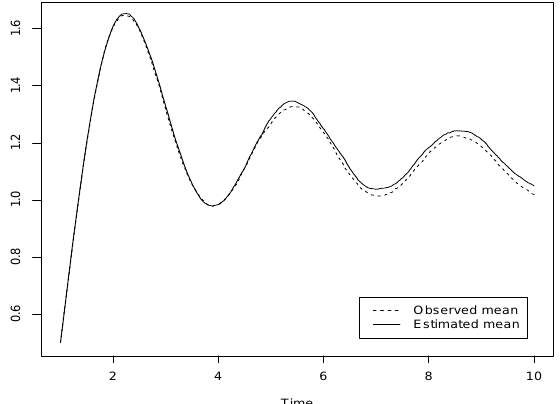
Figure 7. Simulated and estimated mean functions. Oscillabolastic lognormal-type diffusion